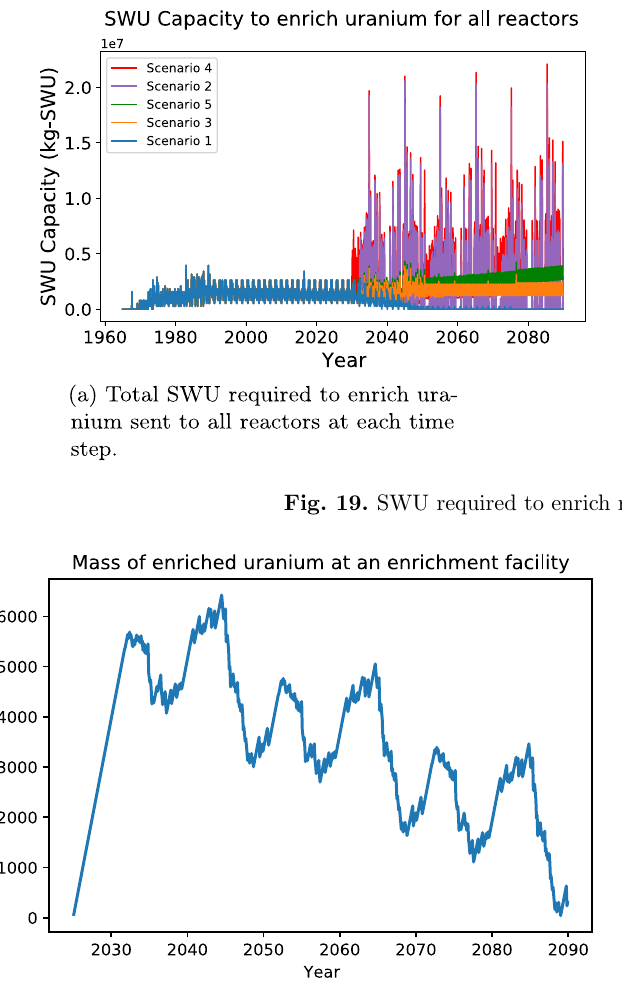
Fig. 20. Net enriched uranium mass stored at a theoretical enrichment facility with a mass throughput of 66 tU/month. This model assumes the facility goes online in 2025 and does not account for any time required for fuel